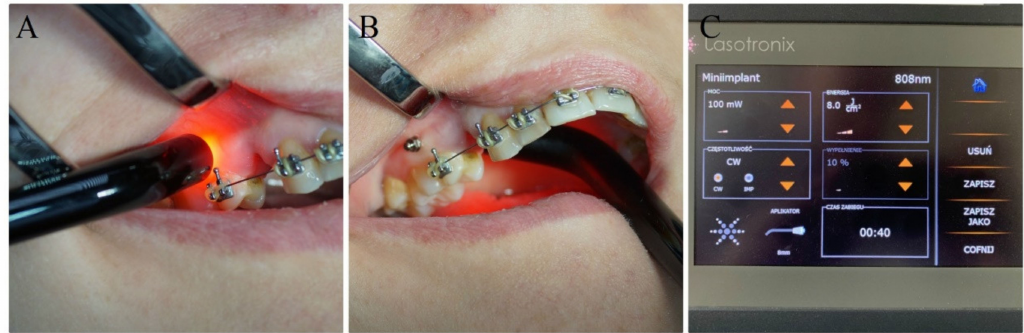
Figure 3. LLLT with the 808 nm laser buccally ( A ) and palatally ( B ) to the maxillary arch. ( C ) The 808 nm semiconductor laser (SmartM PRO, Lasotronix,